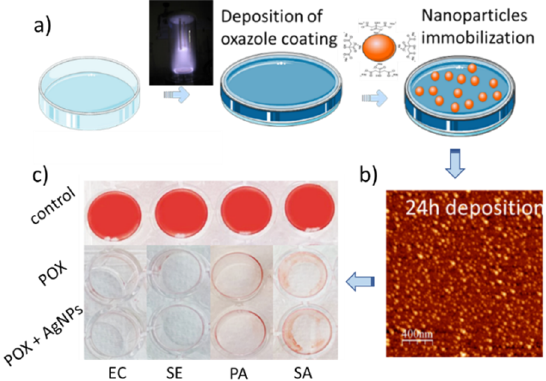
Figure 5. Preparation of silver nanoparticles decorated surfaces and their capacity to inhibit bacterial growth. ( a ) Substrates were first modified by a 20 nm thin layer of oxazoline based plasma polymer (POX). Silver nanoparticles (AgNPs) were synthesised in solution and covalently immobilized by immersion of the substrate for 24 h. ( b ) An AFM (Atomic Force Microscopy) image visualising the silver nanoparticles immobilised to the substrate. ( c ) The POX and POX + AgNPs modified surfaces completely inhibit the growth of E. coli (EC), S. epidermidis (SE), P. aeruginosa (PA) and S. aureus (SA), while bacteria easily form biofilm on the control (red colour is staining with Safranin-O). Note that the POX coating is intrinsically non-biofouling (discussed above and shown in Figure 2), while the AgNPs release silver ions to eliminate bacteria in the vicinity of the substrate.